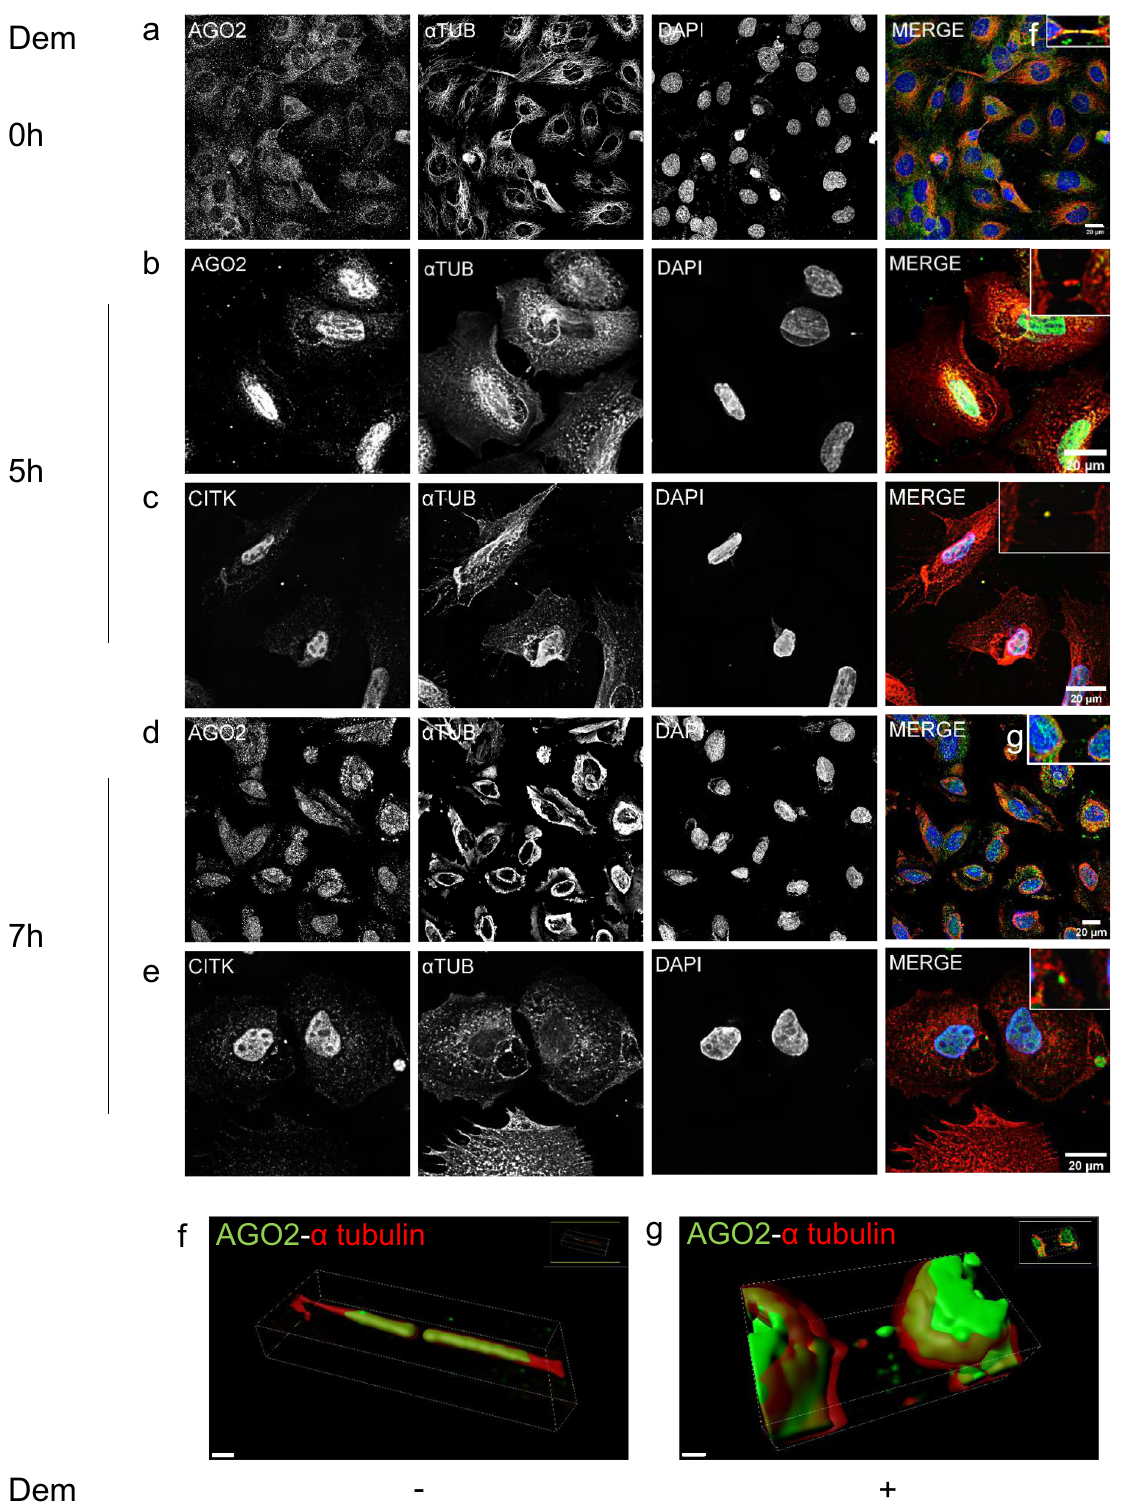
Fig. 5 α -Tubulin alterations and cytoskeletal changes in fl uence AGO2 localization. Representative images of NTHY ori 3-1 cells a before treatment with Demecolcine (Dem) and at b , c 5 h, and d , e 7 h after treatment. a , b , d , f , g AGO2 was stained green, a – g α -Tubulin red and c , e CITK green. Nuclei of cells were visualized in blue (DAPI). The scale bar is 20 μ m. 3D surface reconstruction by Imaris of the cytokinetic bridges f before (scale bar: 15 μ m) and g after Demecolcine treatment (scale bar: 10 μ